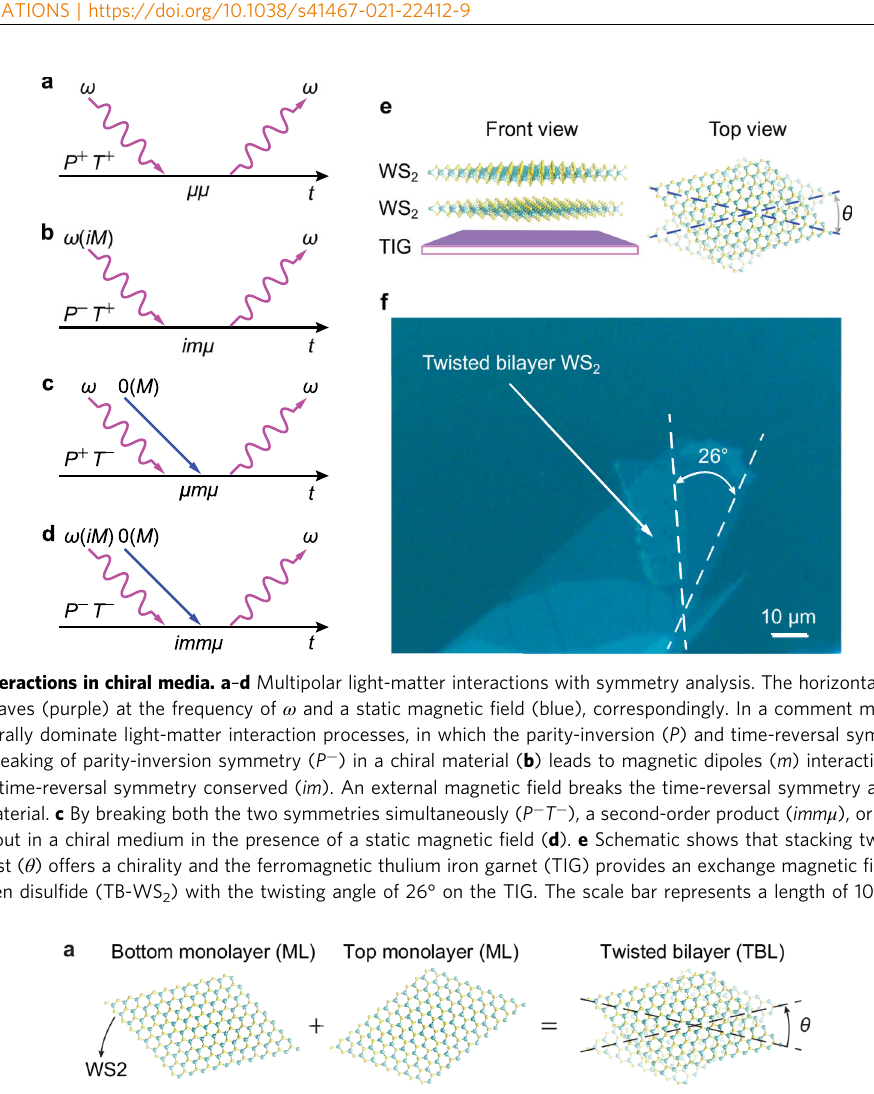
NATURE COMMUNICATIONS| (2021) 12:2088 |https://doi.org/10.1038/s41467-021-22412-9|www.nature.com/naturecommunications